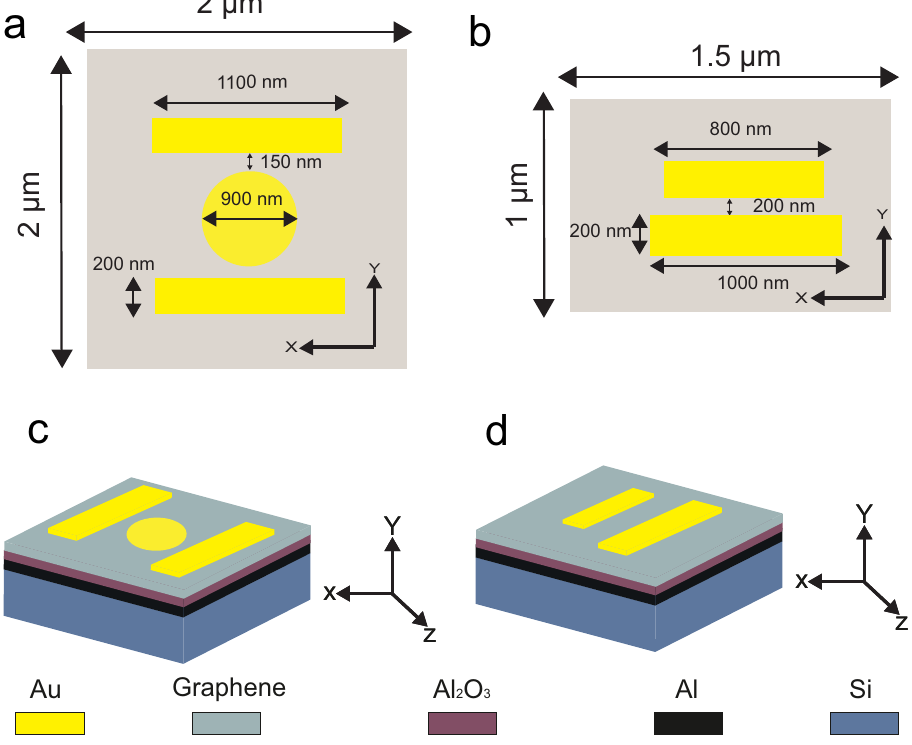
Figure 1. The unit cell of ( a ) the first device with two rectangular antennas and a disk. ( b ) The second device with two parallel rectangular antennas. ( c , d ) 3D schematics of the first and second devices,